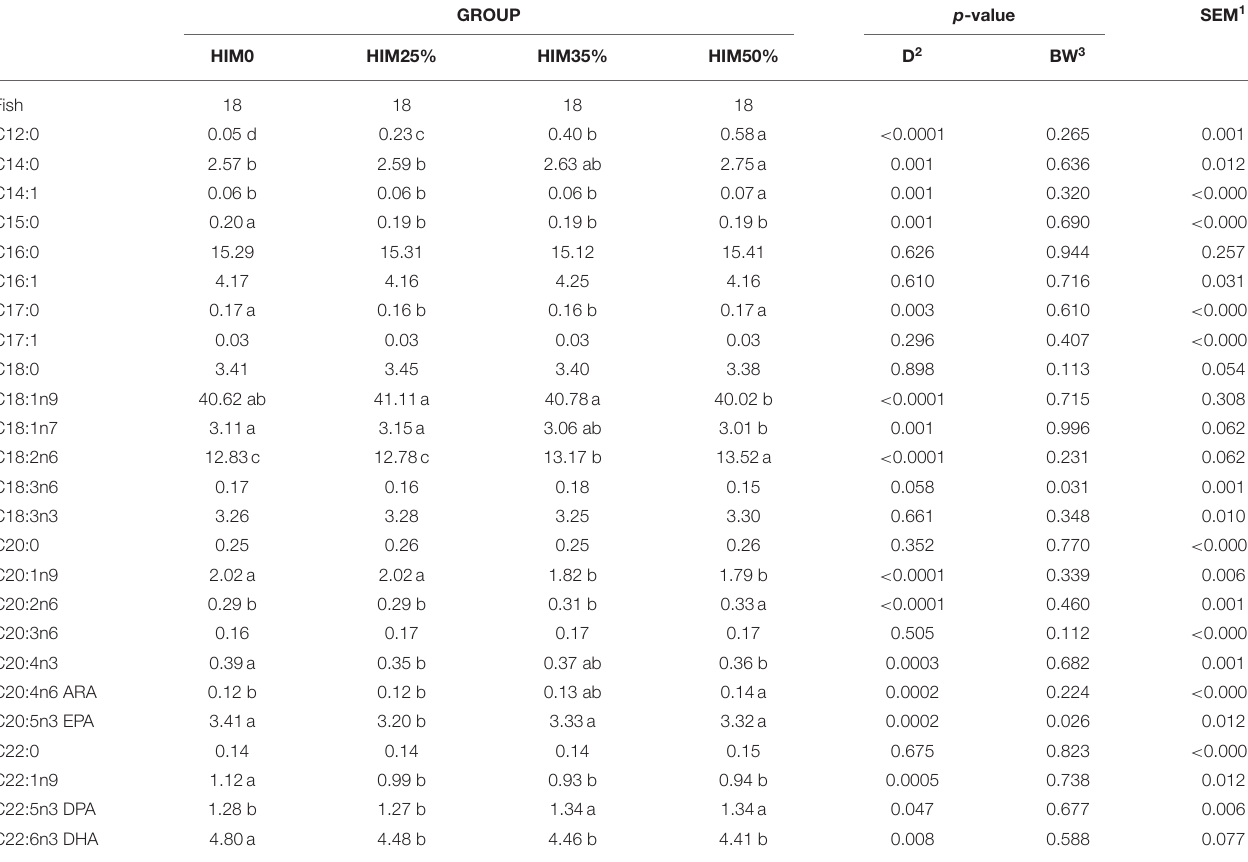
TABLE 5 | Fatty acid composition (g/100g of fatty acid methyl esters) # of the filets of the gilthead sea bream fed with the four exerimental diets. GROUP p -value SEM 1 HIM0 HIM25%